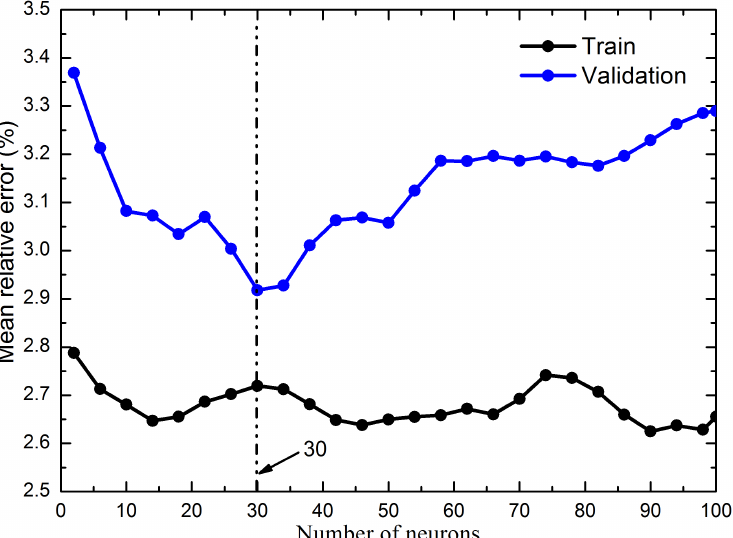
Figure 2. Mean relative error of the training and validation for different numbers of hidden